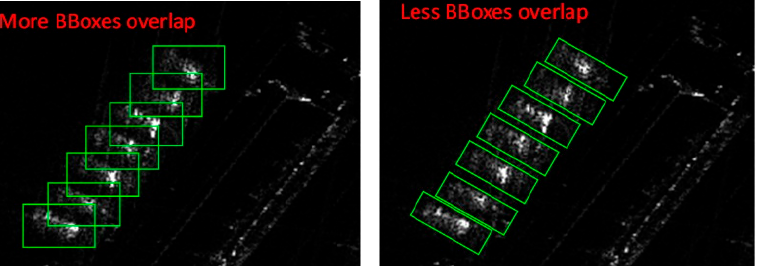
Figure 2. Comparison of horizontal bounding box and rotated bounding box. The left picture shows that horizontal bounding box leads to much overlap, while rotated bounding box does not.